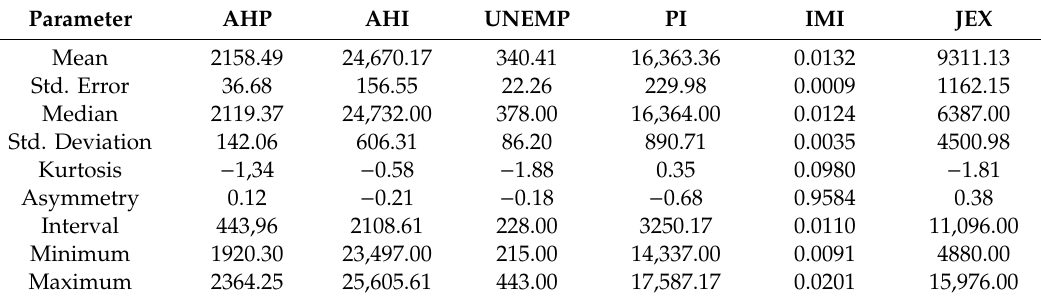
Table 4. Descriptive statistics of regional economic